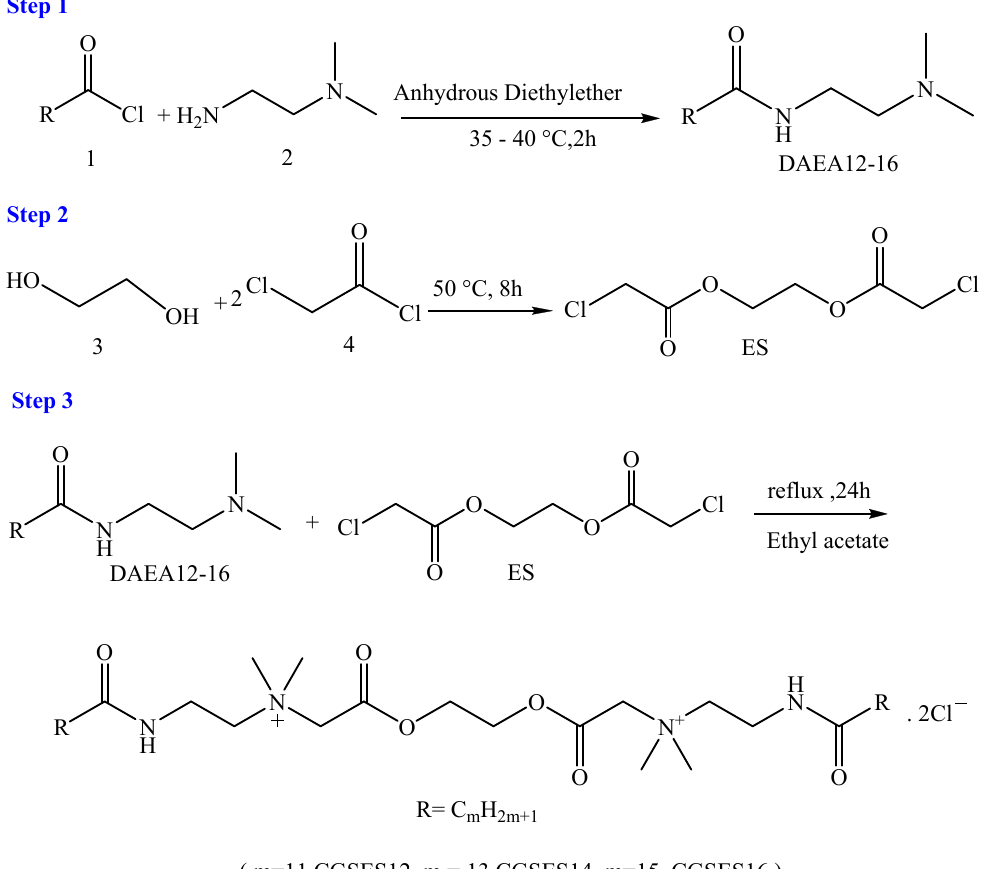
Table 1. FT-IR data of cationic gemini surfactant